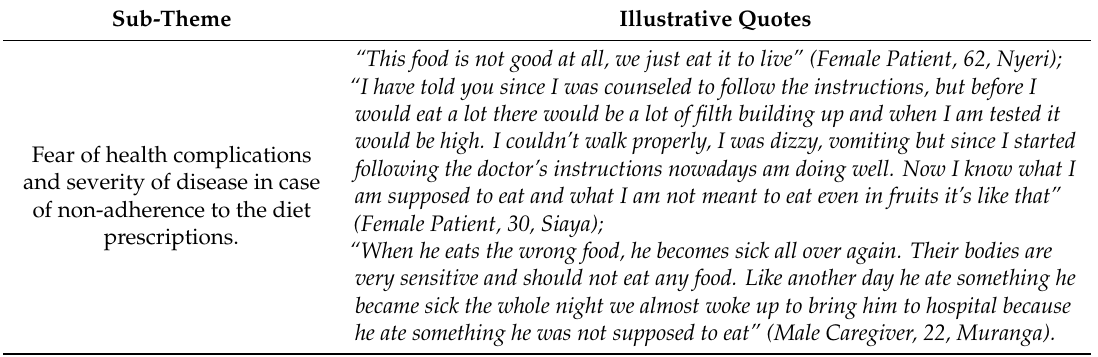
Table 6. Sub-theme 6—illustrative quotes on “fear of health complications and severity of